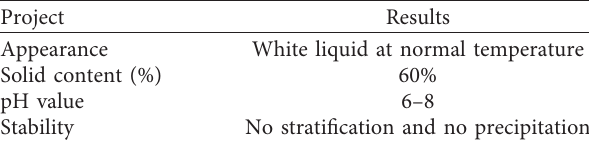
Table 5: Properties of defoaming